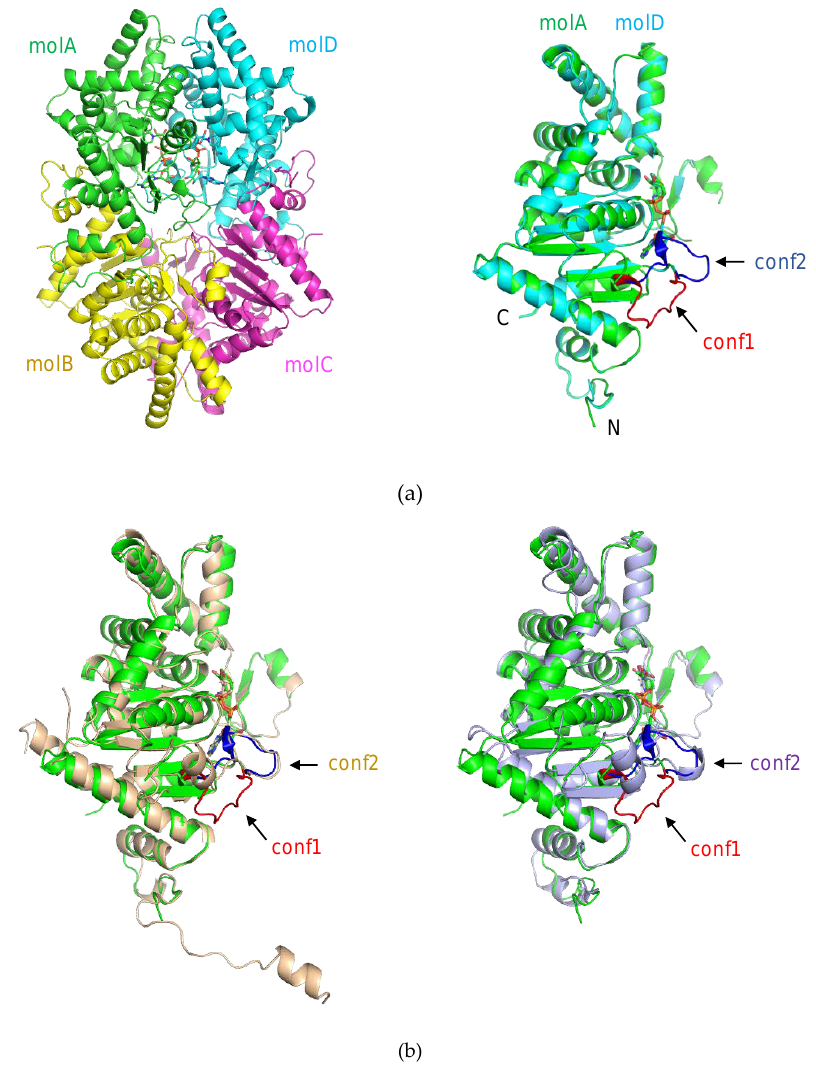
Figure 1. Crystal structure of deoxyhypusine synthase (DHS). The protein and NAD + is shown by the ribbon and stick, respectively. ( a ) Overall structure of Pyrococcus horikoshii OT3 DHS ( Pho DHS): (left) A tetramer of Pho DHS in an asymmetric unit with monomeric units colored green (molA), yellow (molB), magenta (molC) and cyan (molD). (right) Superimposition of molD (cyan) onto molA (green). A loop (V288 – P299) around the NAD + binding site is observed in two different conformations (blue and red) in molA (conformation 1, conf1) and molD (conformation 2, conf2), respectively. While the conf1 in molA is away from NAD + , the conf2 in molD moves towards NAD + . ( b ) Structural superposition of Pho DHS (green) with human (wheat, PDBID:1DHS) and Trypanosoma brucei (light purple, PDBID:6DFT) DHS. The conf1 and conf2 loop in the comparison molecules are labeled (in their respective colors), and the loop in conf1 (red) of molA is added for comparison. Although the overall structures of DHS are similar, there is a significant structural difference in a loop region (V288 – P299) that forms part of the active site of Pho DHS. This active site loop is flexible and presents itself in multi-conformations, conf1 and conf2 in molA and molD, respectively, which